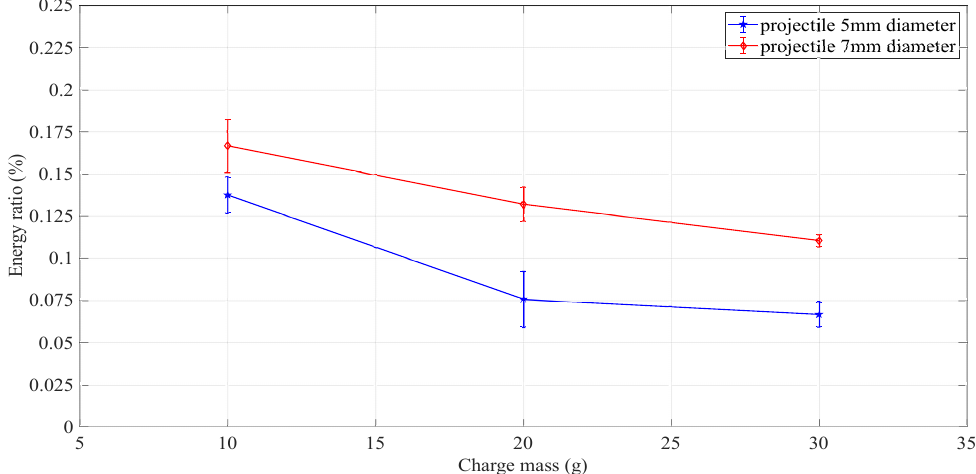
Figure 11. Percentage of energy transmitted from the charge to the 5 and 7 mm projectiles as function of charge